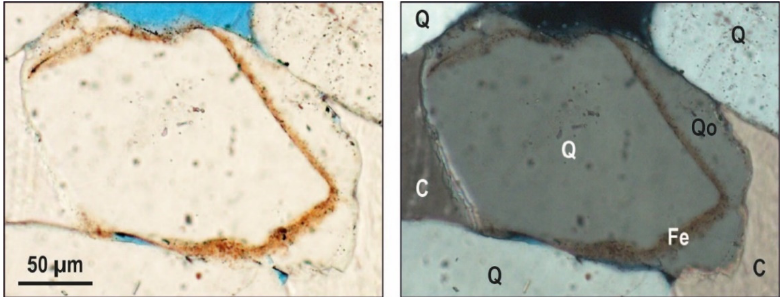
prior to the Neogene uplift [27,52]. The wells in which the mineralogical composition was studied are shown on the map where the mineralogical maturity regions are outlined and which comprise the low maturity region to the NW with high content of feldspars, among others, and the high maturity region to the SE with abundant quartz.